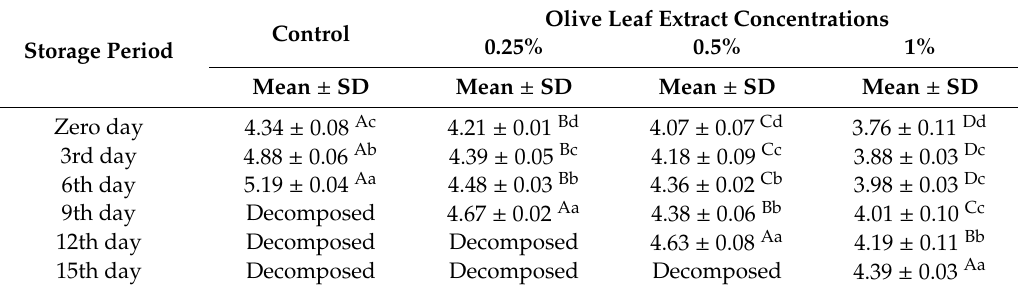
Table 8. Pattern of the staphylococcal count (log10 cfu / g) in poultry meat treated with di ff erent concentrations of olive leaf extract during the chilling storage period at 4 ± 1 ◦ C (mean ± standard deviation “SD”).